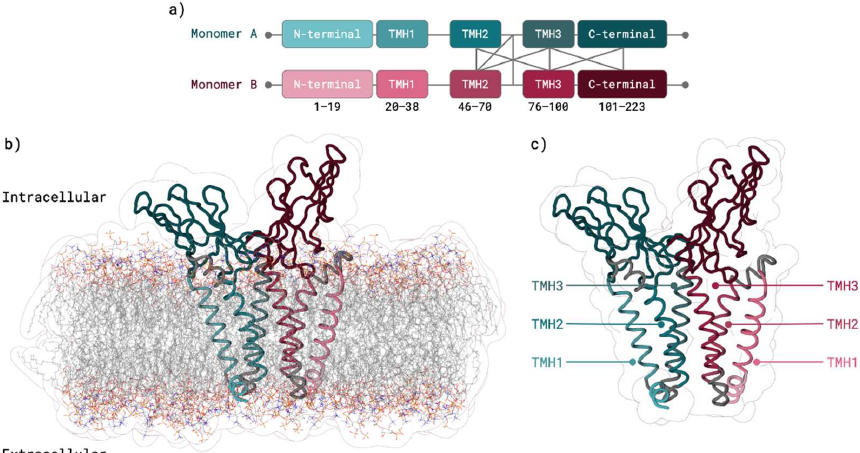
Figure 3. SARS-CoV-2 M protein dimer HADDOCK [44] prediction using TMHMM [34,35] based monomers. ( a ) Interaction representation between Monomer A (teal), and Monomer B (garnet) domains. ( b ) M protein dimer within the membrane: Monomer A (teal), and Monomer B (garnet). ( c ) M protein dimer with TMH domains highlighted: Monomer A (teal), and Monomer B (garnet).